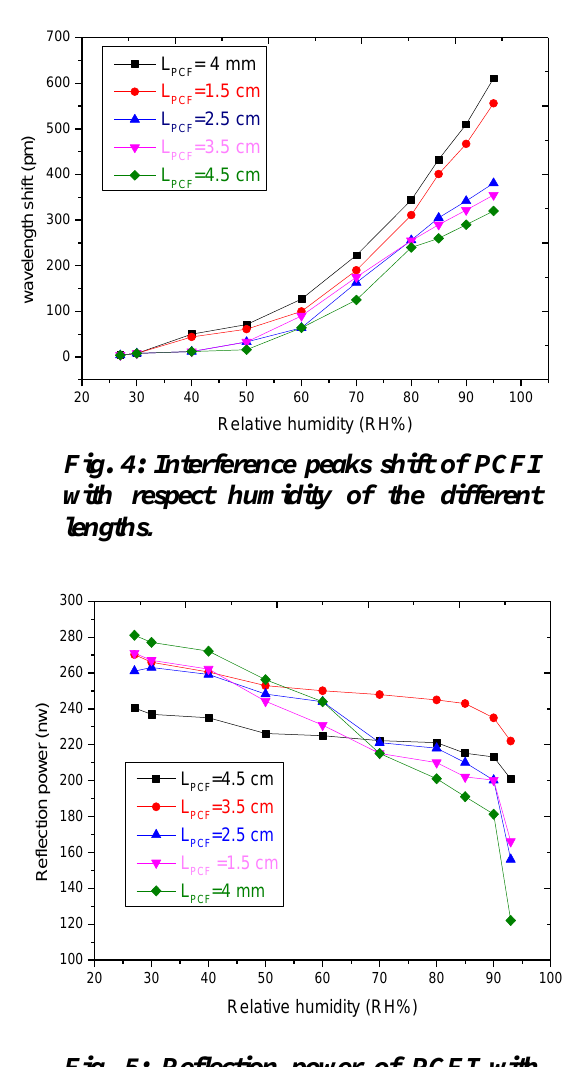
Fig. 5: Reflection power of PCFI with respect humidity of the different lengths .